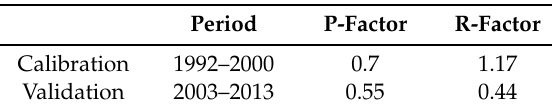
Table 6. Calibration and validation statistics for modelled baseline daily runoff in the Yongding river